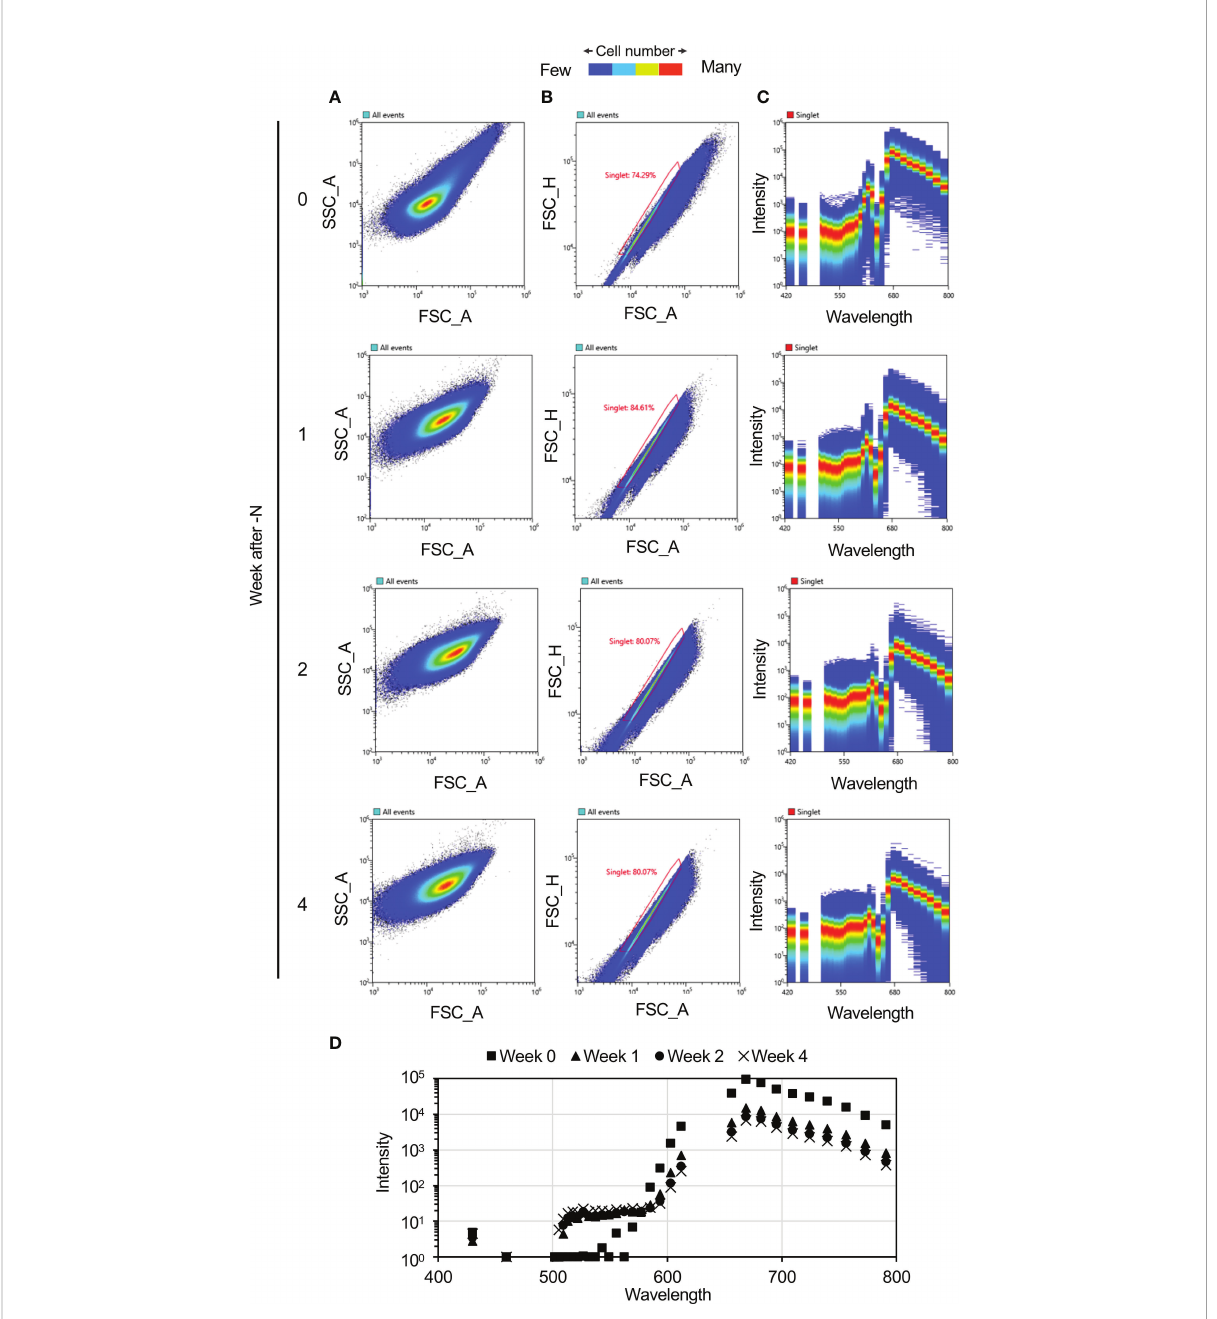
FIGURE 2 Auto fl uorescence spectra of the cultured cells. Plots were generated using a Spectral Cell Analyzer SA3800 (SONY). (A, B) Scatter plots of Cyanidioschyzon merolae cells exposed to N-depletion at the indicated times as weekly intervals using a Spectral Cell Analyzer SA3800. (A) Scatter plot showing forward-scatter area (FSC_A) vs . side-scatter area (SSC_A). (B) Singlet plot showing FSC_A vs . forward-scatter height (FSC_H). Single cells were distinguished based on information in the singlets plot. The percentages shown in this panel denote the percentage of singlets among the analyzed cells. (C) Fluorescence intensity visualization for each cell. The numbers of cells contributing to each plot, by weeks of N-depletion, are as follows: zero week, 1,857,225; one week, 2,115,228; two weeks, 2,150,198; and four weeks, 2,001,770. (D) Average fl uorescence intensities of the cells at weekly